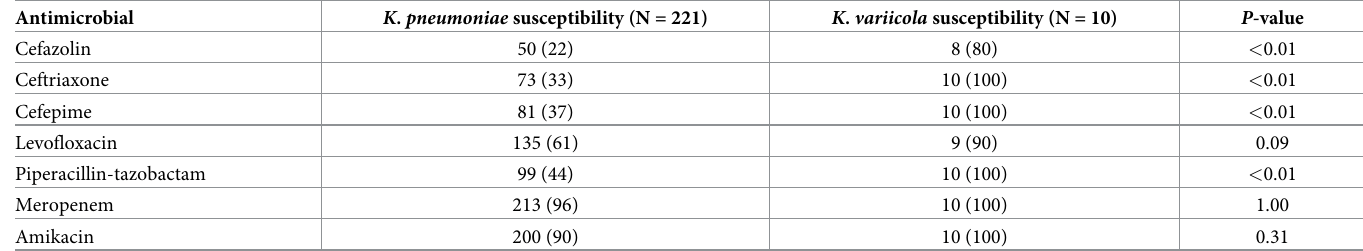
Table 4. Antimicrobial susceptibilities of Klebsiella variicola compared with Klebsiella pneumoniae isolates, No. (%). Antimicrobial